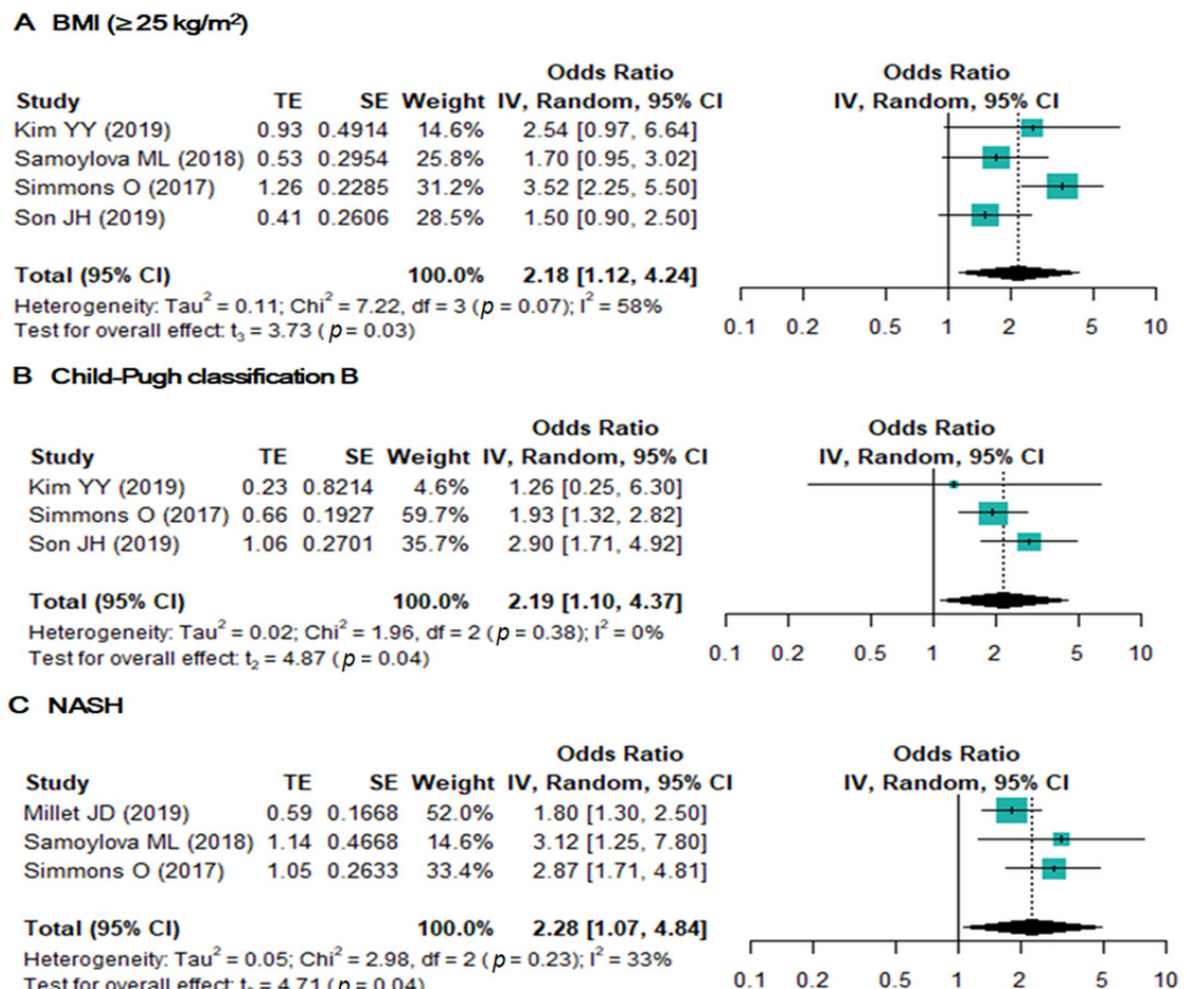
Figure 3. Forest plots of the odds ratios of BMI ( ≥ 25 kg/m 2 ) ( A ), Child–Pugh classification B ( B ), and NASH ( ≥ 100 ng/mL) ( C ).